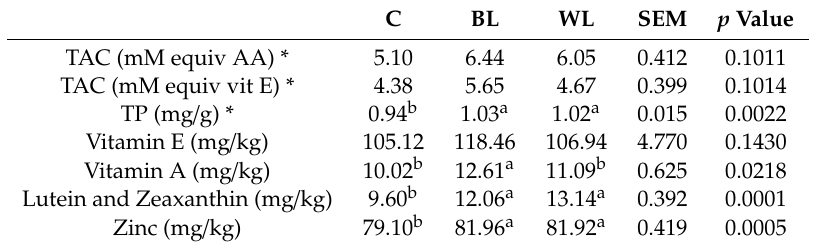
Table 4. The oxidative stability-influencing parameters in egg yolks, collected at the end of the